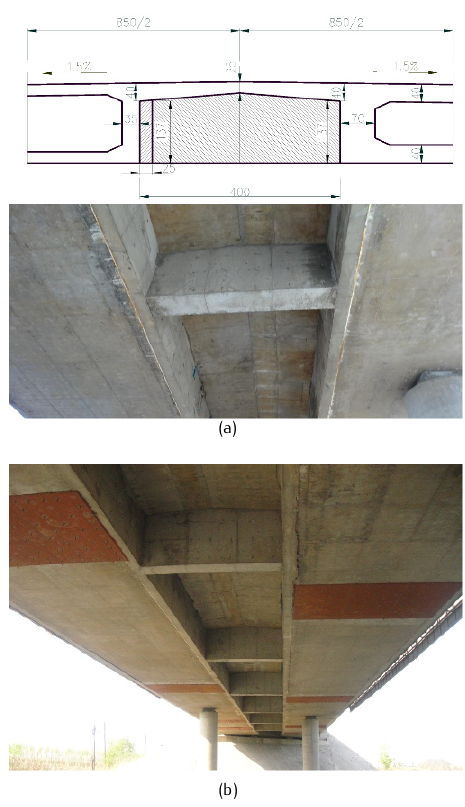
Figure 7. The layout of cross beams between two box girders: (a) The view of cross beam after finished, (b) The longitudinal view of cross beams